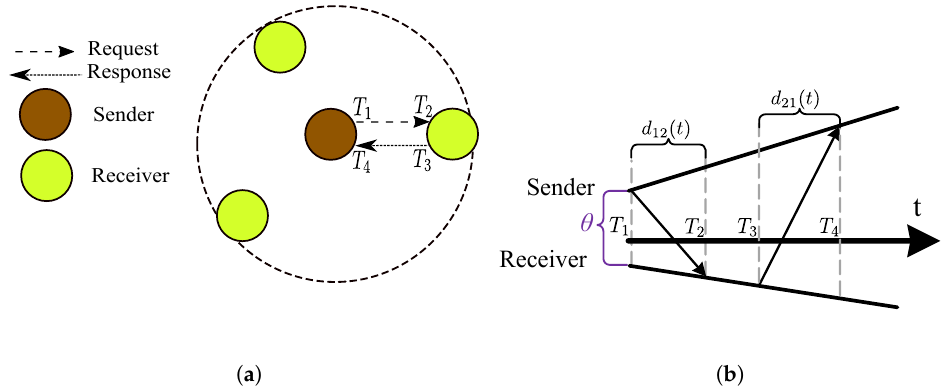
Figure 15. Two-way messaging scheme, where a node initiates a synchronization message exchanges by sending a synchronization request to another node while also storing its time report locally. The receiver responds back to the sender with its time report. In ( a ), a typical operation of the scheme, and in ( b ), the timeline of message exchanges.